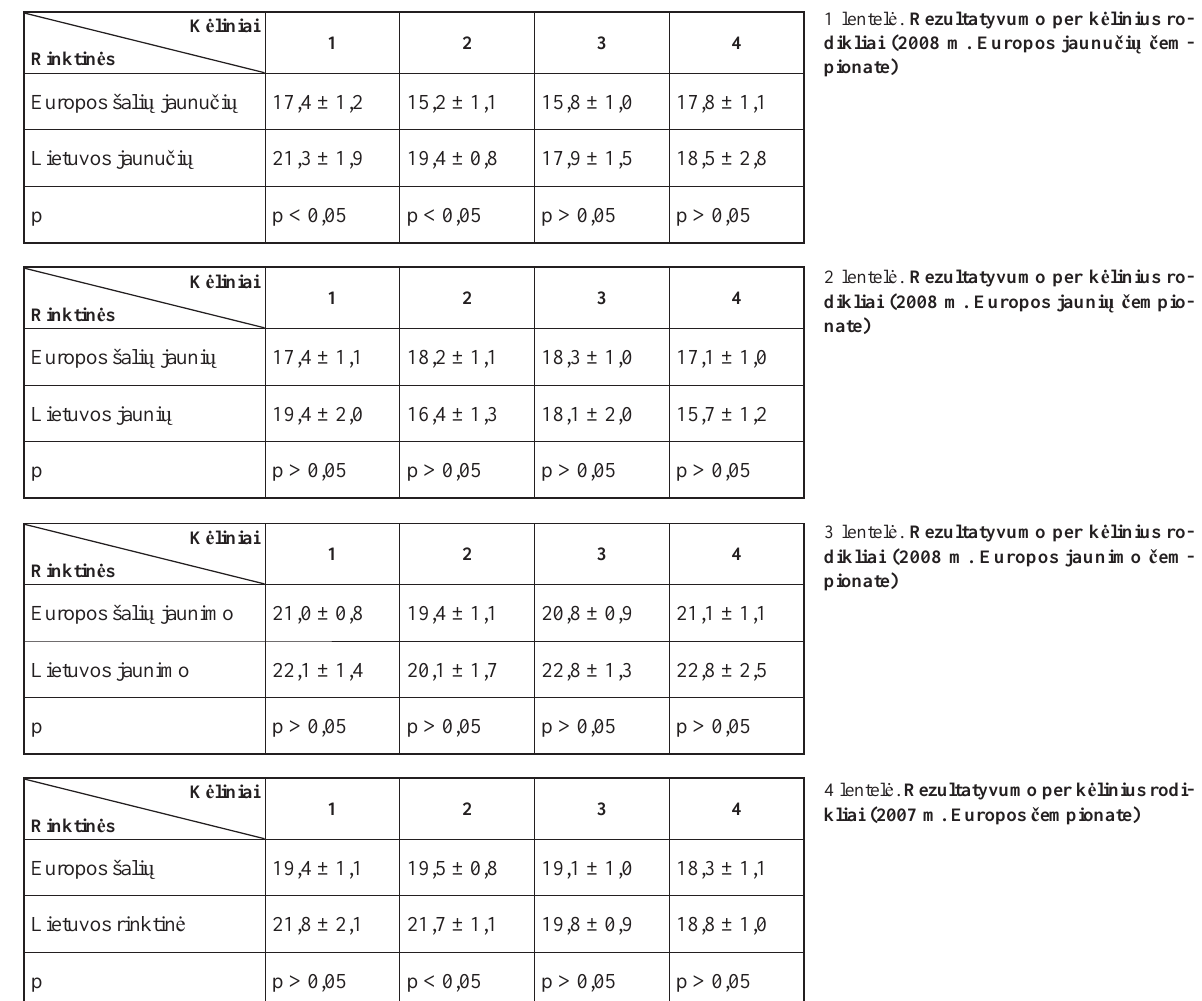
pos šali ų jaunu č i ų rinktin ė s daugiausia tašk ų peln ė per ketvirt ą ( x = 17,8 ± 1,1), mažiausiai per antr ą ( x = 15,2 ± 1,1 taško) k ė lin į . Europos ir